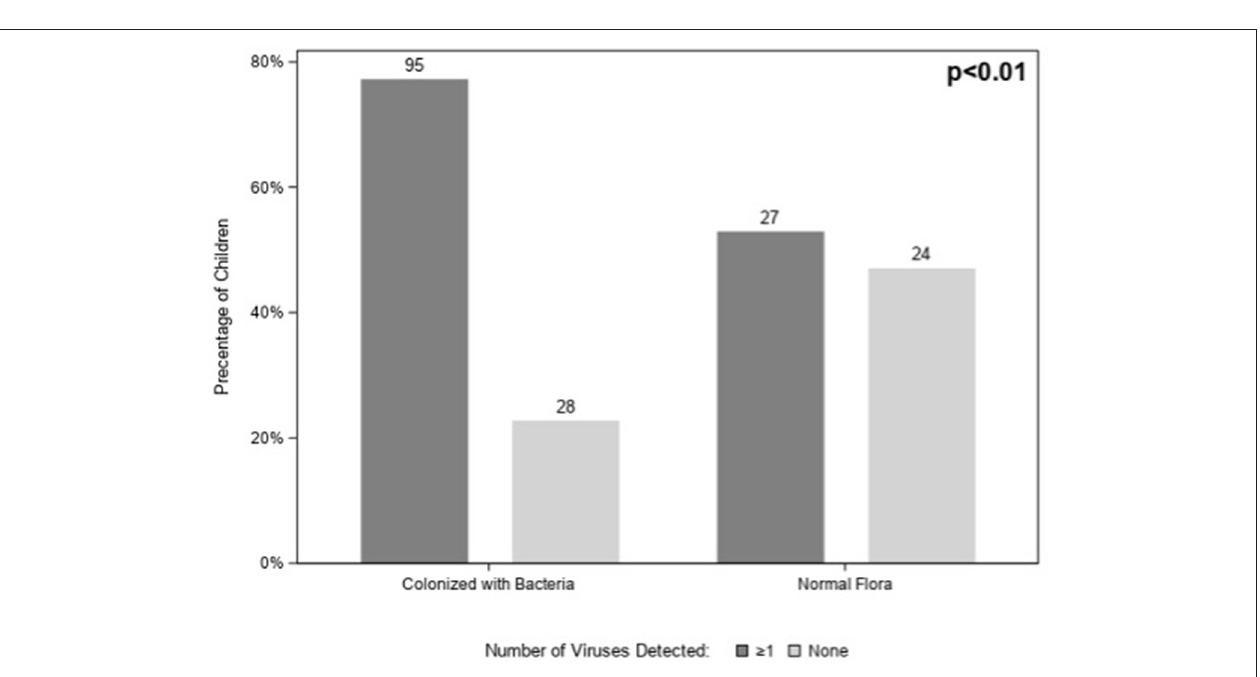
FIGURE 2 | Number of viruses detected among children with acute sinusitis according to the presence of nasopharyngeal